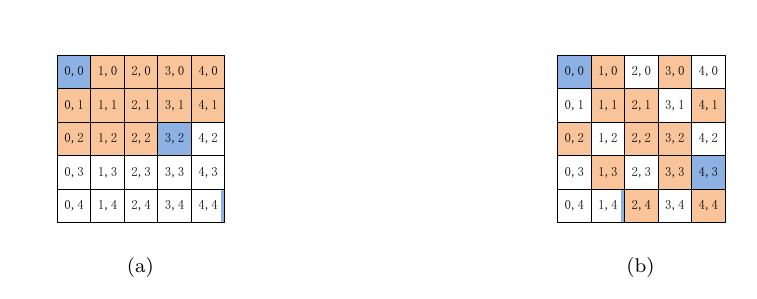
Figure 18: Initialize State with Key, Padding and Nonce in Ketje Jr v1 (a) and v2 (b)